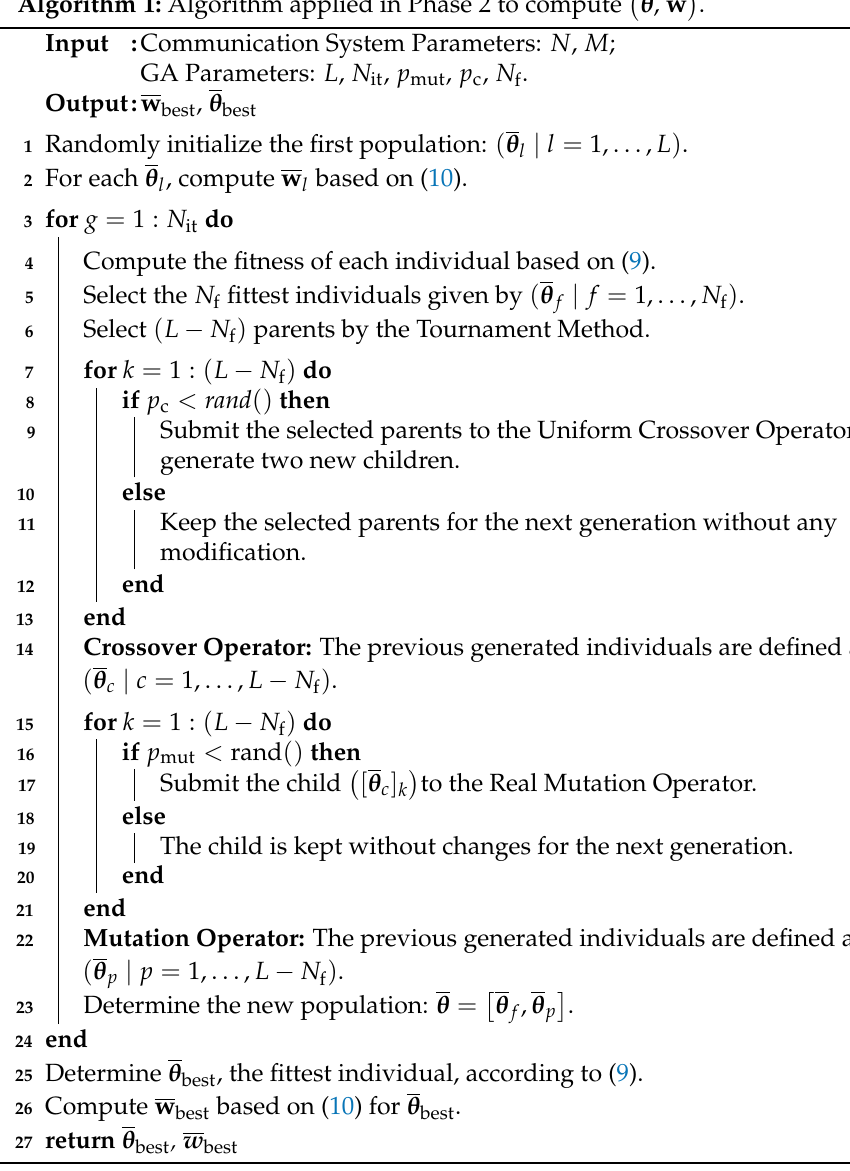
(cid:0) (cid:1) θ , w